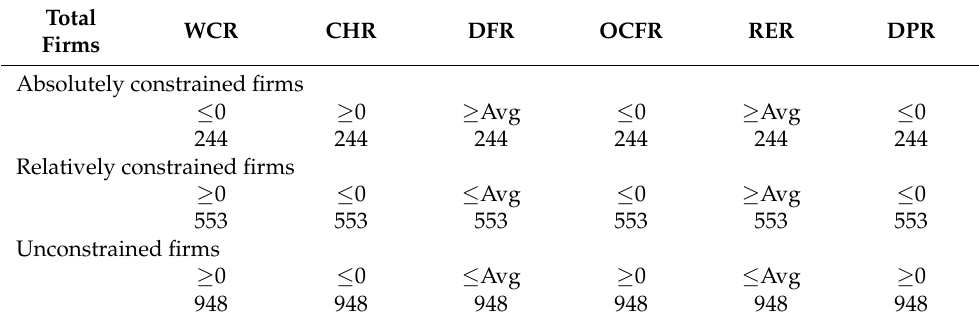
Table 2. Classification of the constrained and unconstrained